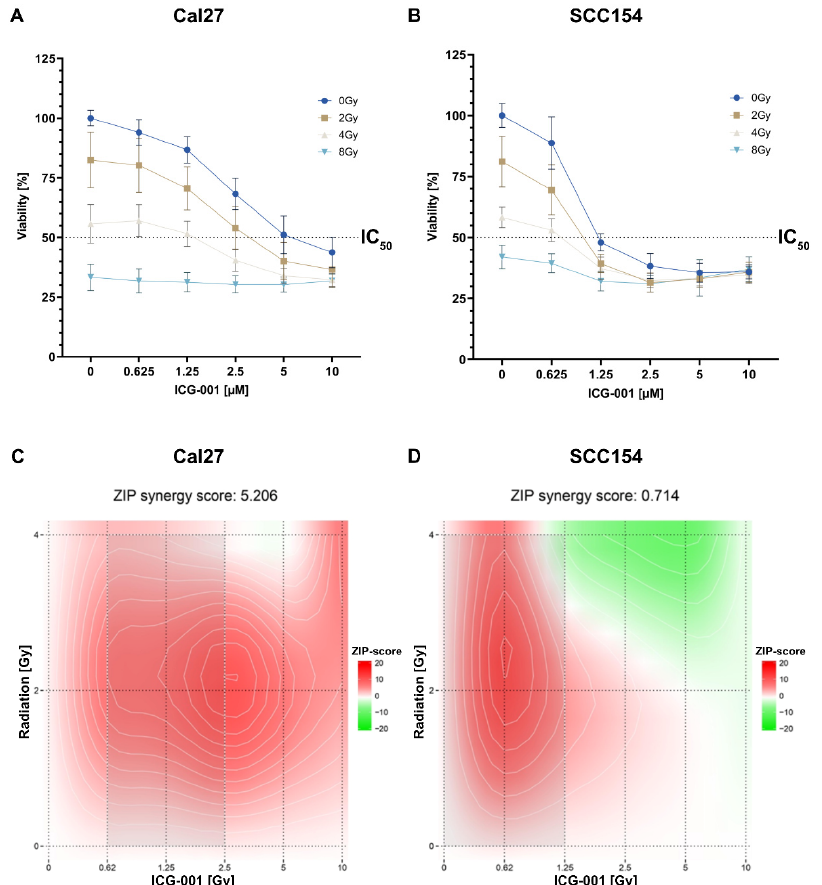
Figure 3. ICG-001 treatment specifically reduces cell proliferation in HPV-positive HNSCC cells in a dose-dependent manner, and its effect can be augmented by concomitant irradiation of the cells. Changes in cell viability in SCC154 ( A ) and Cal27 ( B ) cell lines following treatment with ICG-001 and irradiation. ( C , D ) Graphical illustration of the combinatorial analysis of ICG-001 inhibition and irradiation in regard to cell viability of Cal27 ( C ) and SCC154 ( D ) cell line. The Synergyfinder was used, and the Zip score reference model was applied. A score above 10 is regarded as synergistic interaction, between -10 and 10 as additive and less than -10 is regarded as antagonistic interaction. HPV; human papillomavirus, Gy; Gray, IC 50 ; half-maximal inhibitory concentration.